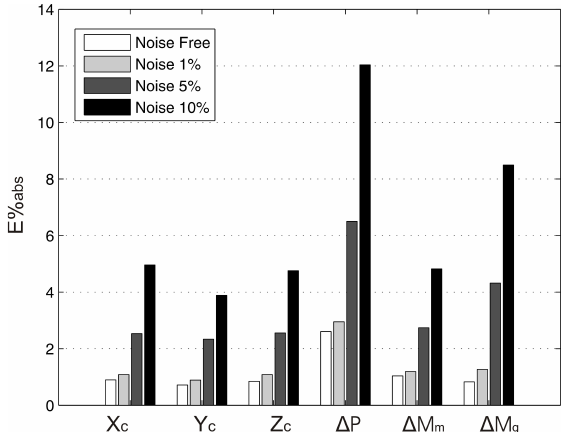
Fig. 6. Mean percent error E % abs for each source parameter using noisy patterns at the inputs of the integrated ANN inverse